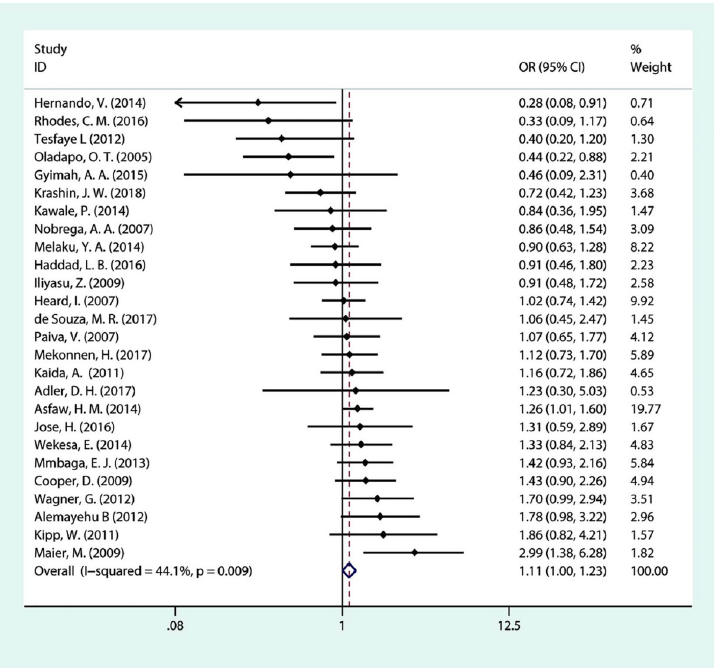
Fig 3. Forest plot of pooled OR for fertility desire in PLHIV (ART experienced vs ART naive).